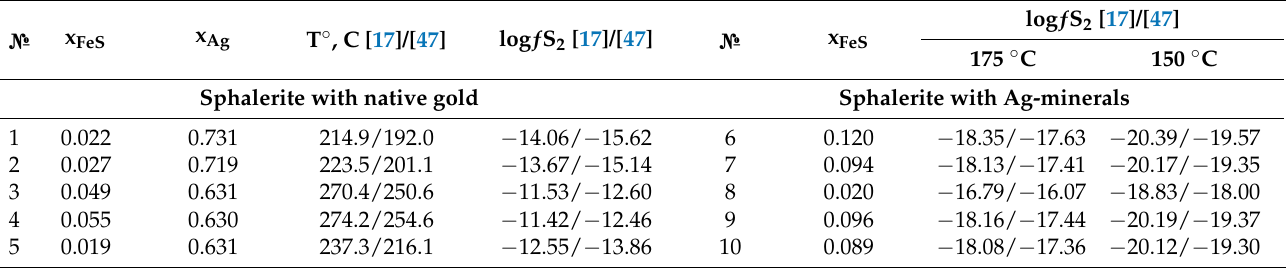
Table 7. Estimated values of the mineral formation temperature and sulphur